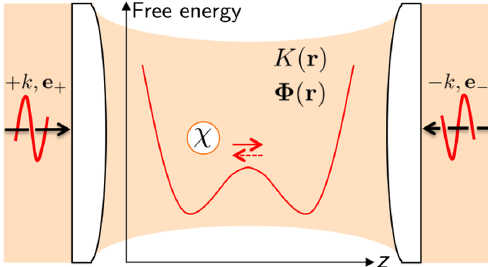
FIG. 1. Schematics of the proposed optomechanical